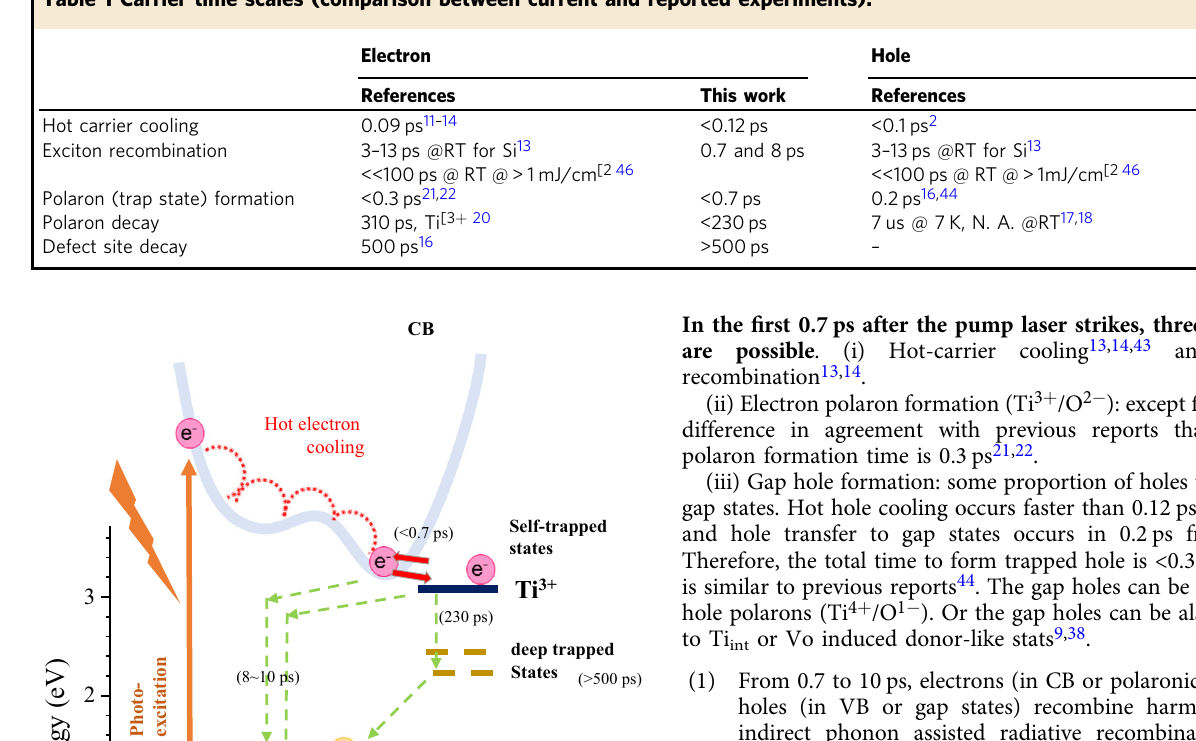
Table 1 Carrier time scales (comparison between current and reported